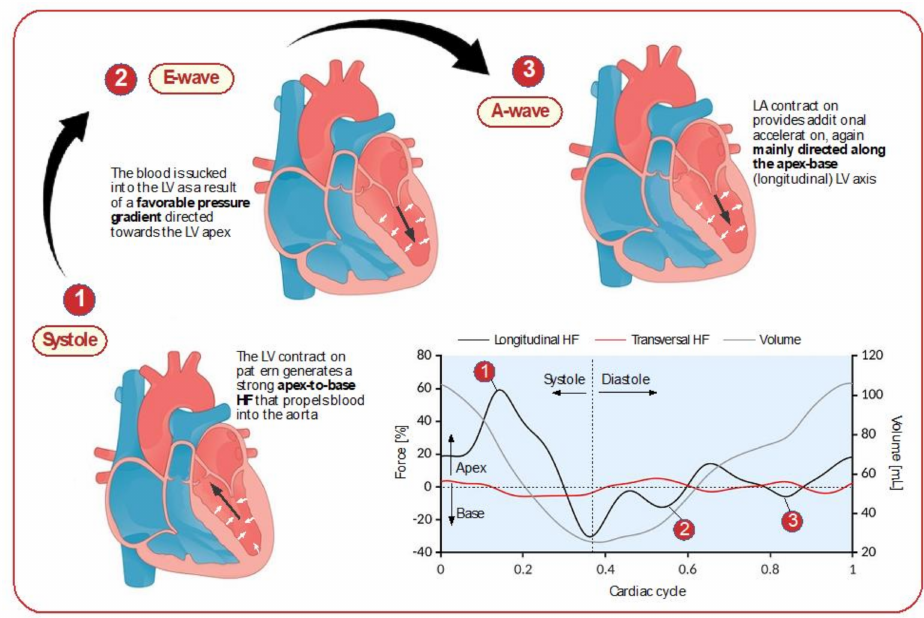
Figure 5. Representation of LV HDFs in the whole cardiac cycle. LV, left ventricular; HDFs, hemody- namic